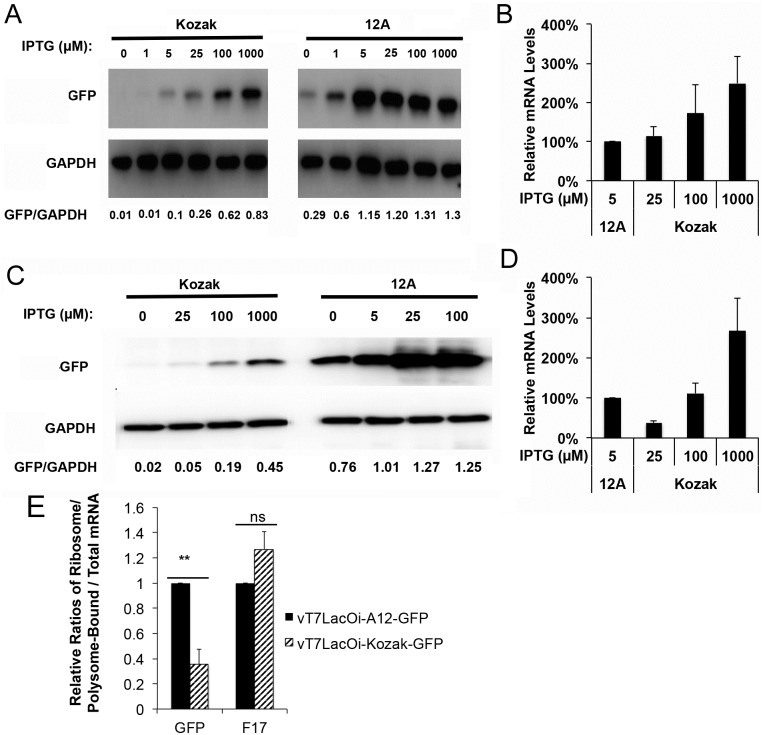
Messenger RNA with a 5’-poly(A) leader is more efficiently translated than mRNA without a 5’-poly(A) leader in VACV-infected cells.(A) HeLa cells were transfected with plasmids expressing eGFP from a T7 promoter and containing an A-tract or a Kozak sequence between the ATG and the T7 promoter. Cells were infected with vT7LacOi 24 h post transfection and different concentrations of IPTG were added to the media as indicated. At 24 hpi, Western blotting tracked eGFP and GAPDH (loading control) expression levels; and eGFP intensity was normalized to GAPDH, shown below. (B) Levels of eGFP mRNA levels for (A) were measured by qRT-PCR, and normalized to 18S rRNA. (C) HeLa cells were infected with recombinant VACV vT7LacOi_Kozak-GFP or vT7LacOi_A12-GFP. Indicated concentrations of IPTG were added to the culture media. At 24 hpi Western blotting tracked eGFP and GAPDH (normalization and loading control) expression, shown below. (D) Levels of eGFP mRNA expression of (C) were measured by qRT-PCR, and normalized to 18S rRNA. (E) HeLa cells were infected with vT7LacOi_A12-GFP or vT7LacOi_Kozak-GFP. Total and ribosome/polysome-bound RNAs were isolated at 15 hpi. The GFP and F17 mRNAs were measured by qRT-PCR and normalized to 18S rRNA. The ratios of ribosome/polysome-bound mRNA to total mRNA were calculated for GFP and F17, respectively. The ratios from vT7LacOi_A12-GFP-infected cells were normalized to one. **indicates a P value < 0.01. ns = Not Significant (i.e. P value > 0.05).